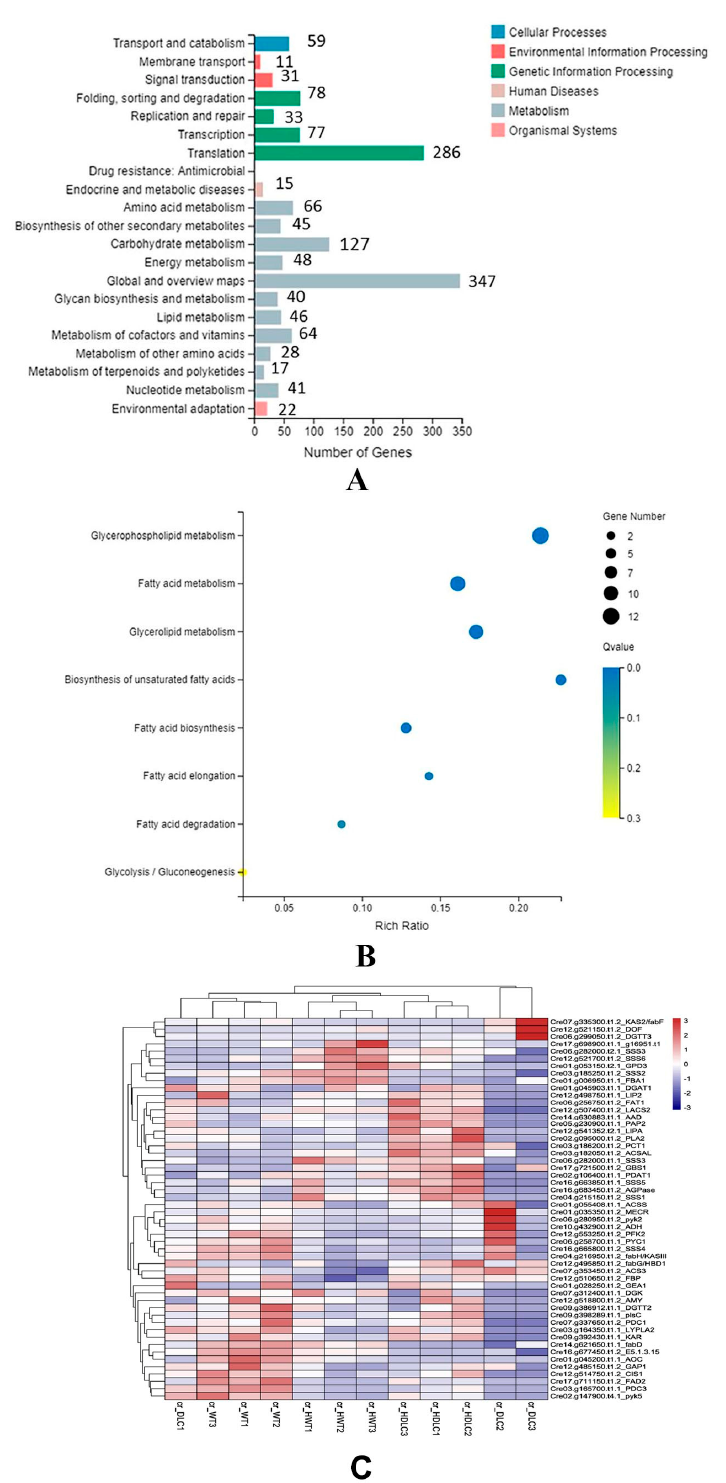
Figure 5. KEGG pathway classification and enrichment of DEGs from DLC vs. WT. ( A ) KEGG pathway classification of DEGs. ( B ) KEGG enrichment of DEGs involved in the lipid metabolism. The Q value ranges from 0 to 0.3. A Q value closer to zero suggests more considerable enrichment. Pathways with Q values ≤ 0.05 were defined as significantly enriched pathways for the DEGs. ( C ) The clustering heatmap of DEGs related to lipid metabolism. For the clustering heatmap, normalized counts were rescaled between − 3 and 3; clustering was based on Pearson